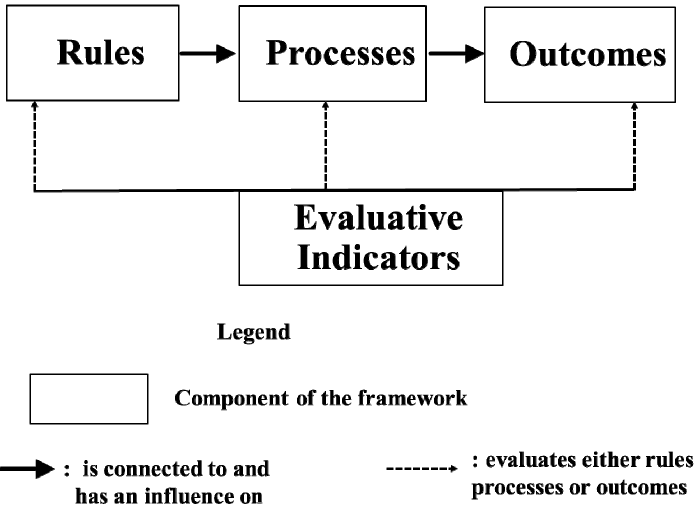
Figure 1. Framework for measuring spatial justice and land tenure security. Developed based on [9,15,18,20,28,66–68].